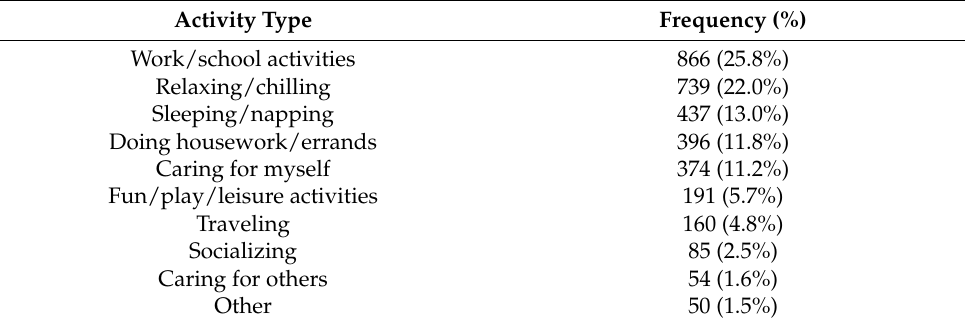
Table 4. Frequency distribution of activity types across all datapoints ( n =